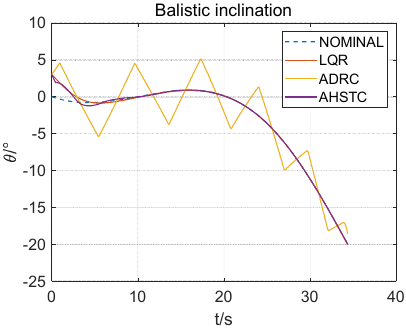
Figure 12. Tracking curve of the trajectory inclination angle θ .